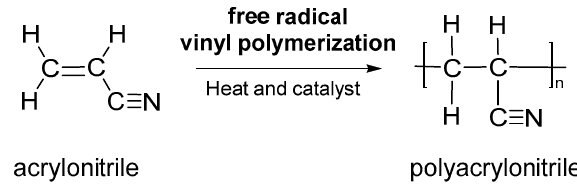
Figure 5. Polymerization of acrylonitrile (AC) to